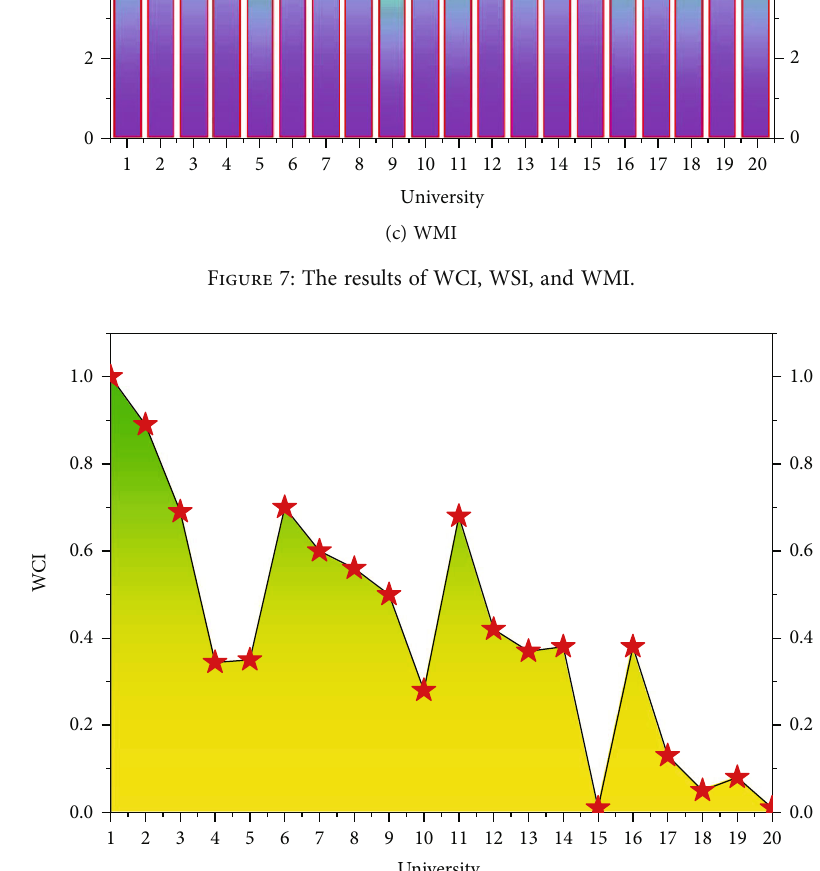
Figure 8: The standardized results of